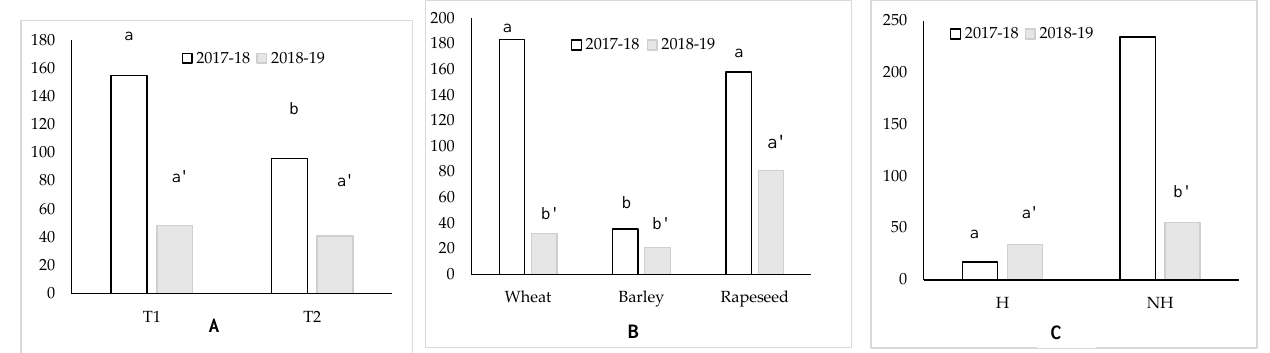
Figure 5. The effects of the management factors ( A ): tillage (T1 and T2); ( B ): crops (Wheat, Barley and Rapeseed); ( C ) herbicide applications (H and NH) and their interactions on the biomass (g/m 2 ) of G. coronaria determined at crop harvest in the two growing seasons. Same superscript letters (a, b and for 2017 – 2018; a ’, b’ and for 2018 – 2019) across treatments are statistically similar according to Duncan test ( p = 0.05).